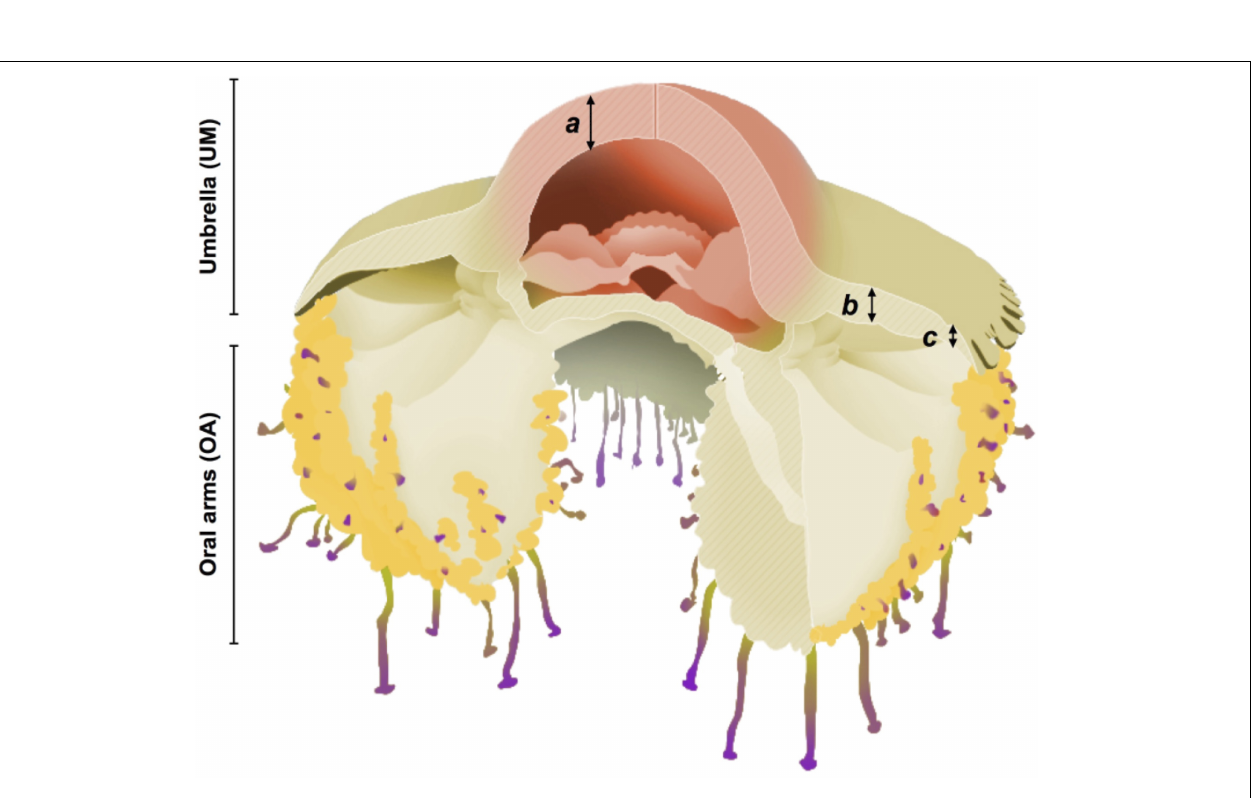
Frontiers in Marine Science |